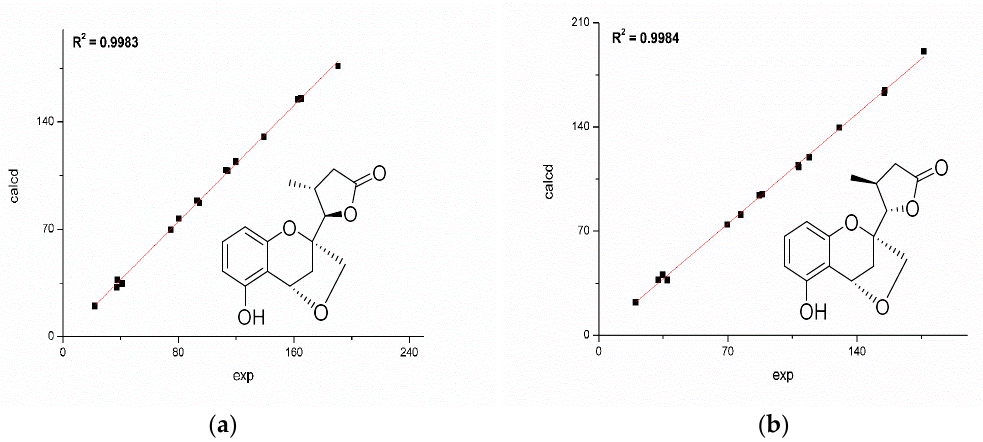
Figure 4. Correlations between experimental and calculated 13 C-NMR chemical shifts of 1a ( a ) and 1b ( b ).